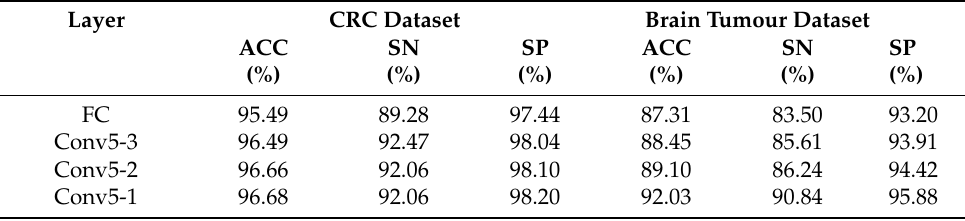
Table 9. Overall classification performance of the 4S-DT model on the CRC and brain tumour testing